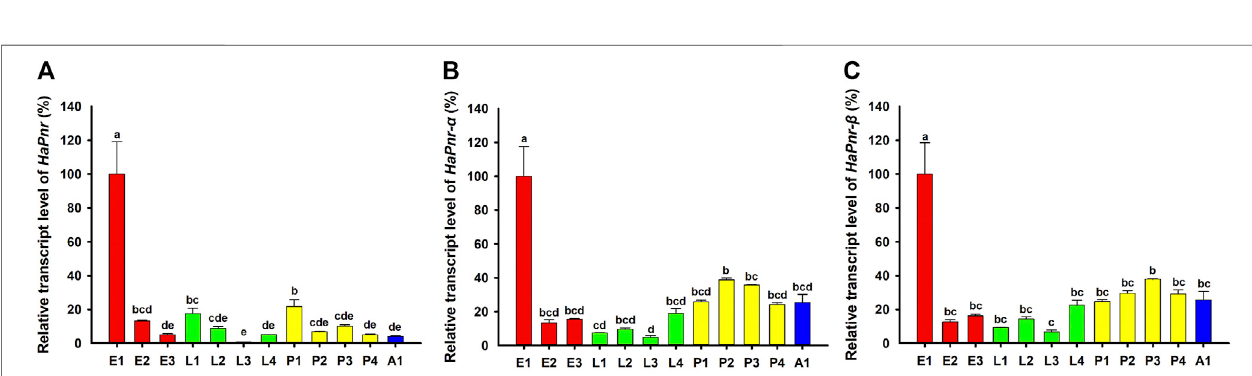
FIGURE 3 | Relative transcript levels of HaPnr (A) , HaPnr- α (B) , and HaPnr- β (C) at different development stages of H. axyridis as determined by RT — qPCR. E1, E2, and E3 represent 1-, 2-, 3-day-old eggs; L1, L2, L3 and L4 represent fi rst, second, third, and fourth instar larvae; P1, P2, P3 and P4 represent 1-, 2-, 3-, 4-day-old pupae; and A1 represents 1-day-old adults, respectively. Different letters above the standard error bars indicate signi fi cant differences based on ANOVA followed by Duncan ’ smultiplecomparisontest( p < 0.05). H.axyridis ribosomalprotein49( Harp49 )wasusedasaninternalreferencegenetonormalizethedifferencesamong the samples. Relative expression levels for HaPnr were calculated based on the highest expressions of HaPnr in the one-day-old egg sample in developmental stage.